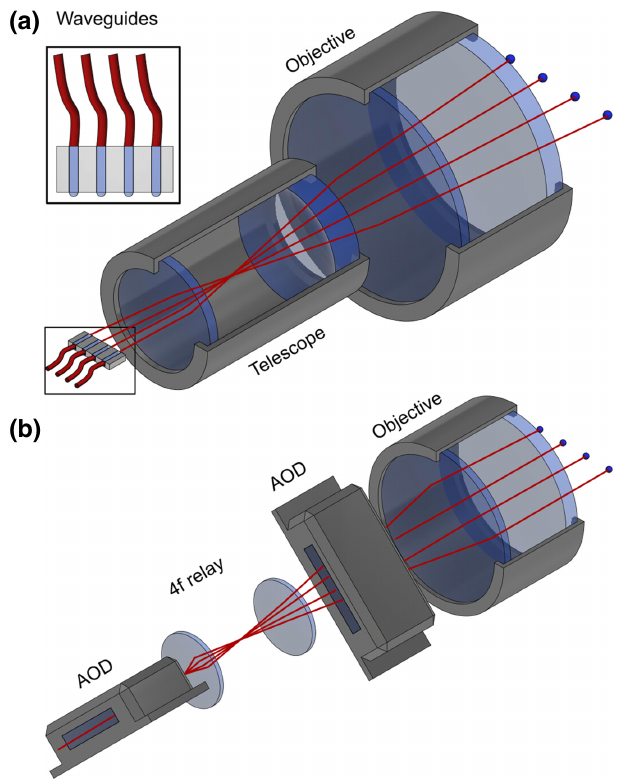
FIG. 6. Simplified illustration of the addressing approaches trialed, dimensions not to scale. (a) A fiber-coupled rigid waveg- uide with micro-optics delivers light via a shrinking telescope to the main objective and onto the ions. Beam separations are fixed. (b) A pair of crossed AODs with a relay telescope delivers light to the main objective and onto the ions. Beam separations are